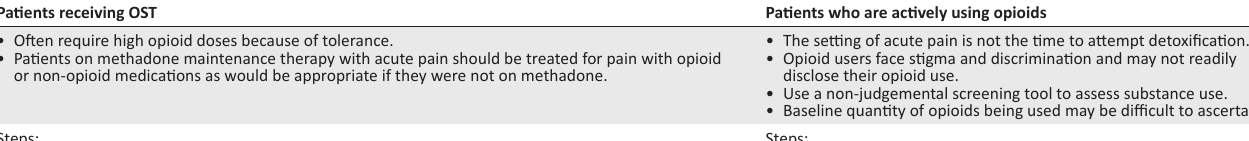
TABLE 5-A3: Assessment and management of acute pain in opioid use disorders. 82,138 Patients receiving